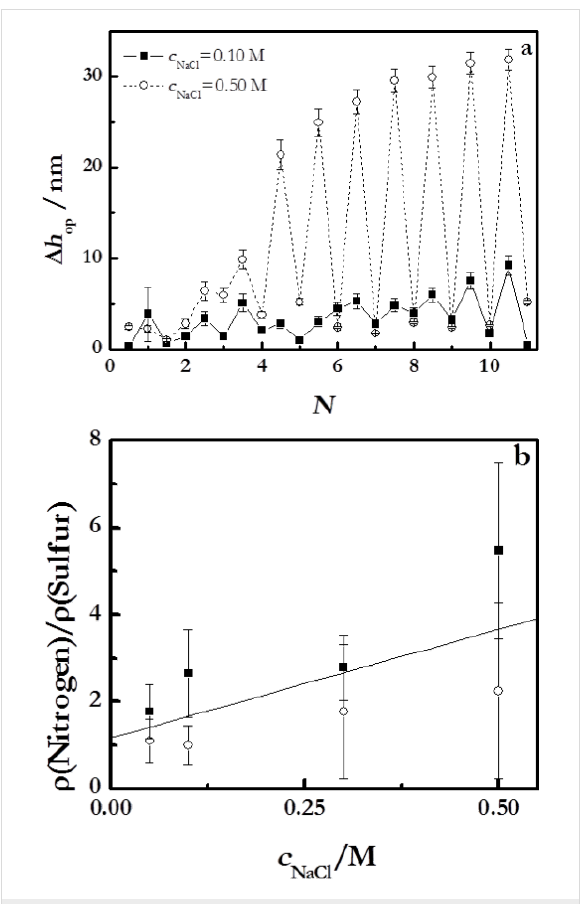
Figure 6: (a) Variation of thickness, obtained using ellipsometry for the adsorption of single layers, as a function of N for (PDADMAC + PSS) N films formed at two different ionic strengths: 0.10 M and 0.50 M. (b) Dependence on the salt concentration of the ratio between nitrogen and sulfur contents in (PDADMAC + PSS) N films obtained from ellip- sometry (solid squares) measurements average over 12 bilayers and by XPS (open circles) measurements at 0°. The solid line is to guide the